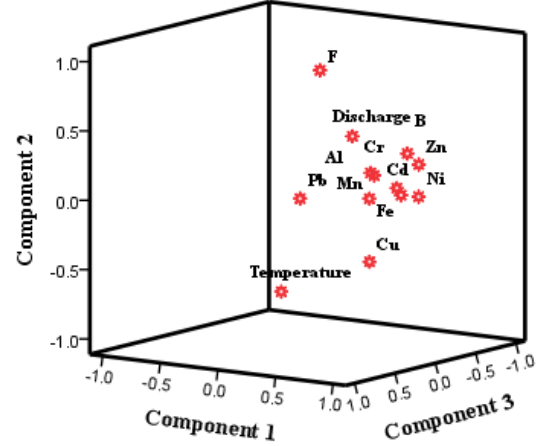
Fig. 4 Factor rotation coefficients diagram